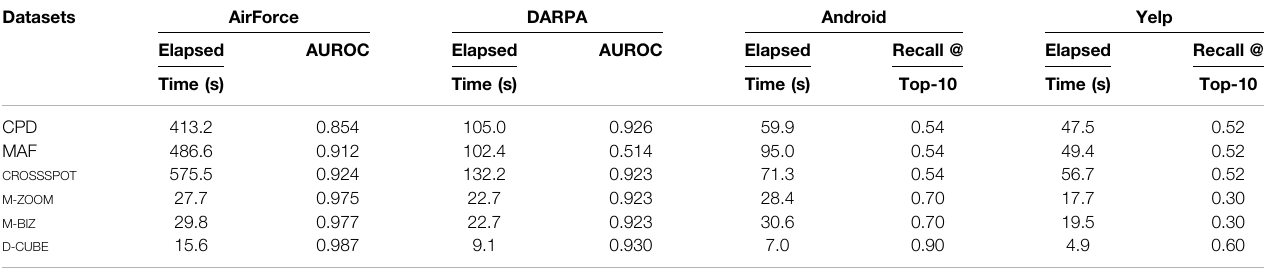
TABLE 4 | D-CUBE spots network attacks and synchronized behavior fastest and most accurately from TCP dumps and rating datasets, respectively. Datasets